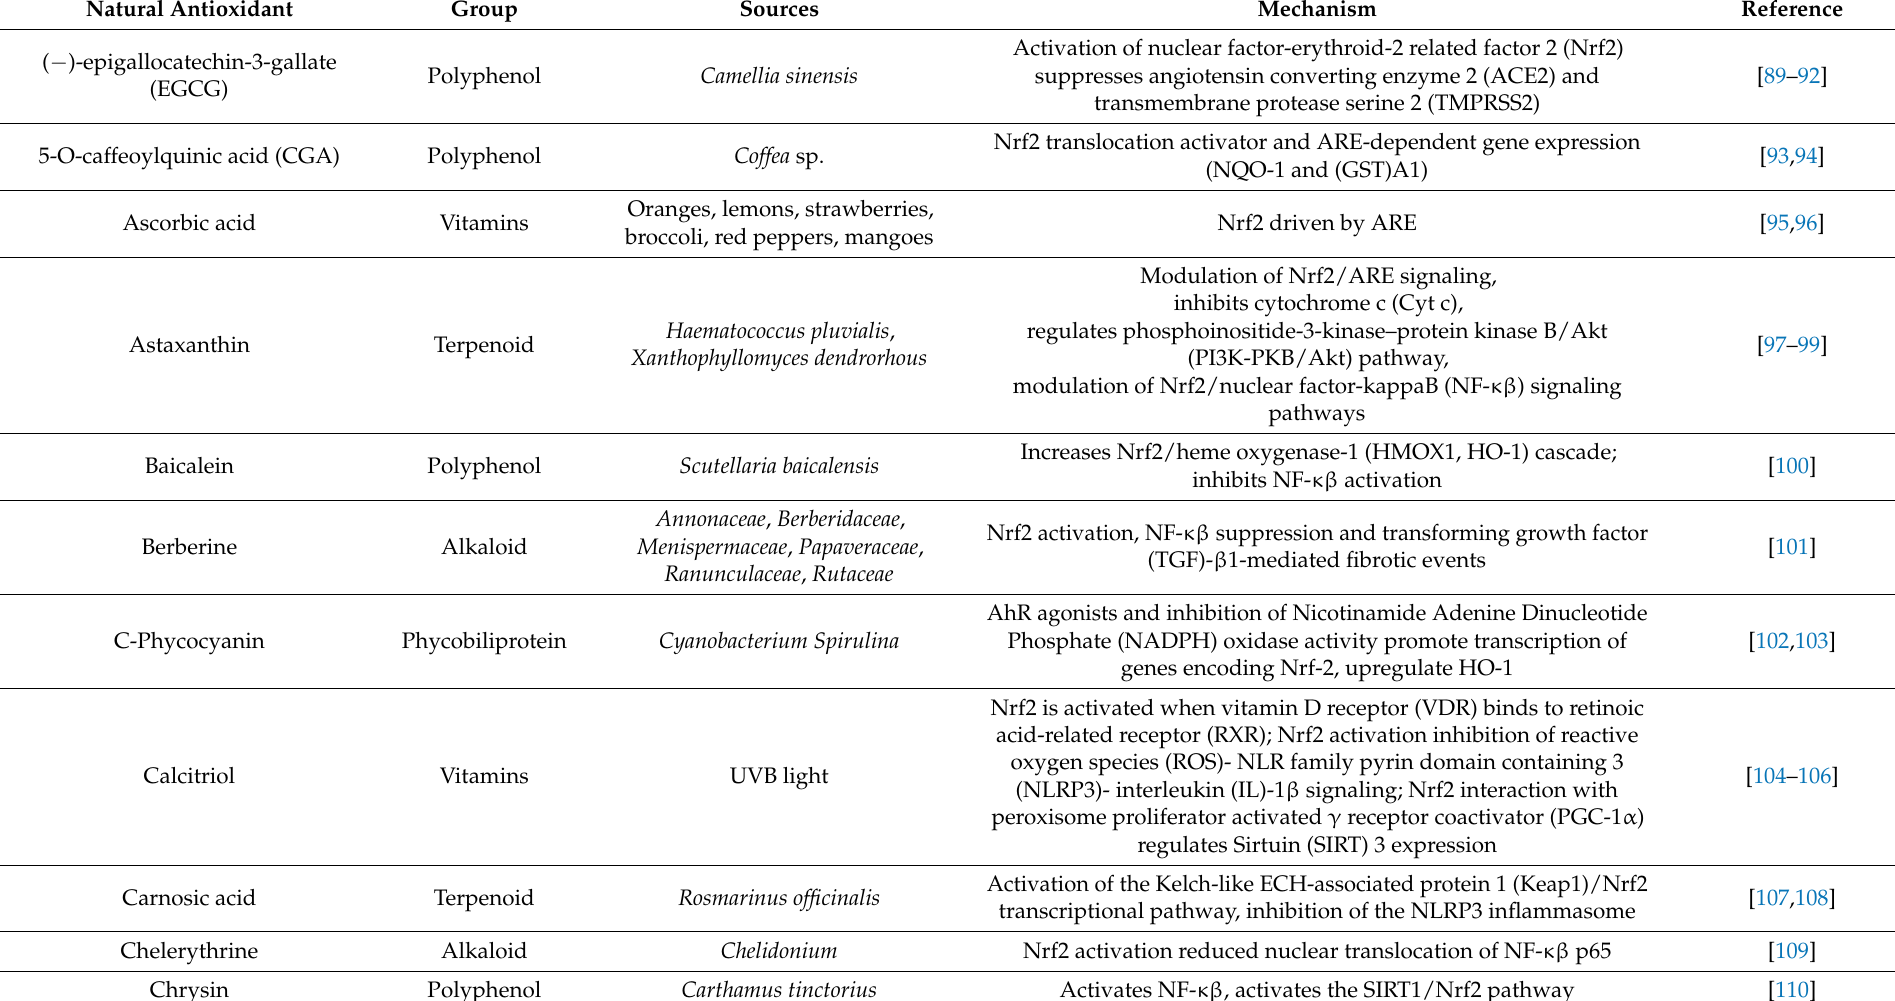
Table 1. The bioactive compounds reported in the literature that can activate